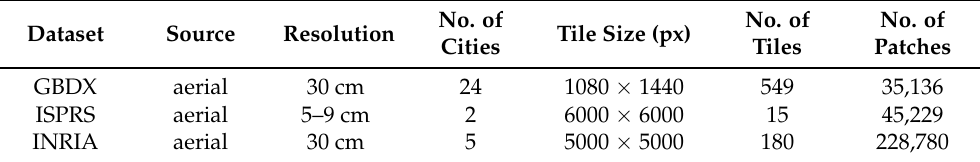
Table 2. Overview of all three datasets used in our study. The GDBX dataset has the largest diversity in terms of different cities. ISPRS stands out in resolution, and INRIA overall has the largest number of patches.